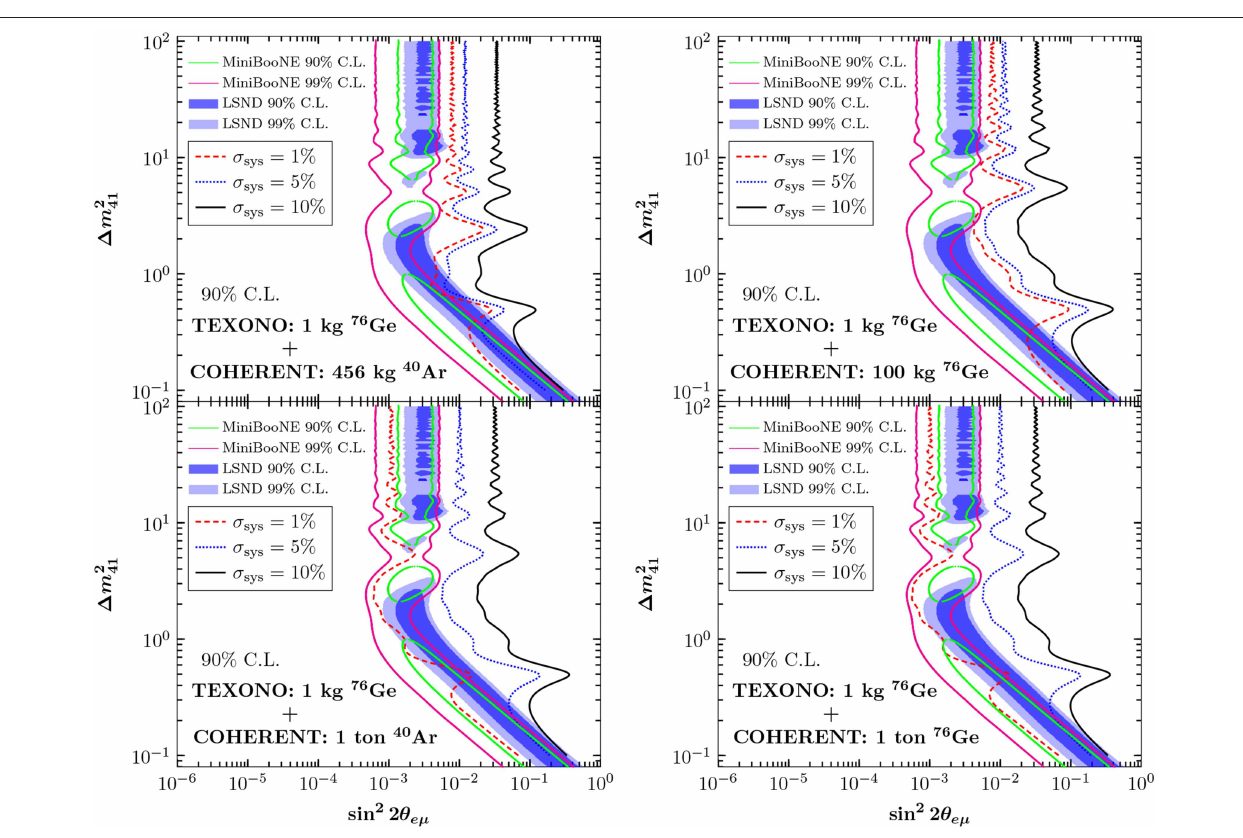
FIGURE 16 | Exclusion curves at 90% C.L. in the ( 1 m 2 41 –sin 2 2 θ e µ ) parameter plane from a combined analysis of COHERENT and TEXONO experiments. The results are compared to existing constraints from MiniBooNE and LSND. Figure reproduced from Kosmas et al. [24] with the permission of the American Physical Society and with updated results from MiniBooNE